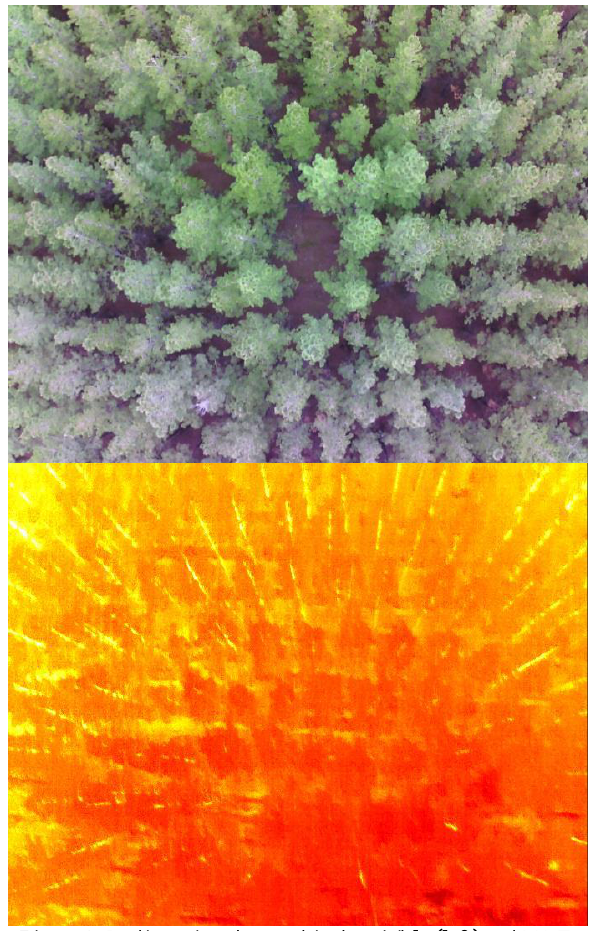
Figure 1: Radiata pine observed in the visible (left) and LWIR (right) spectral bands